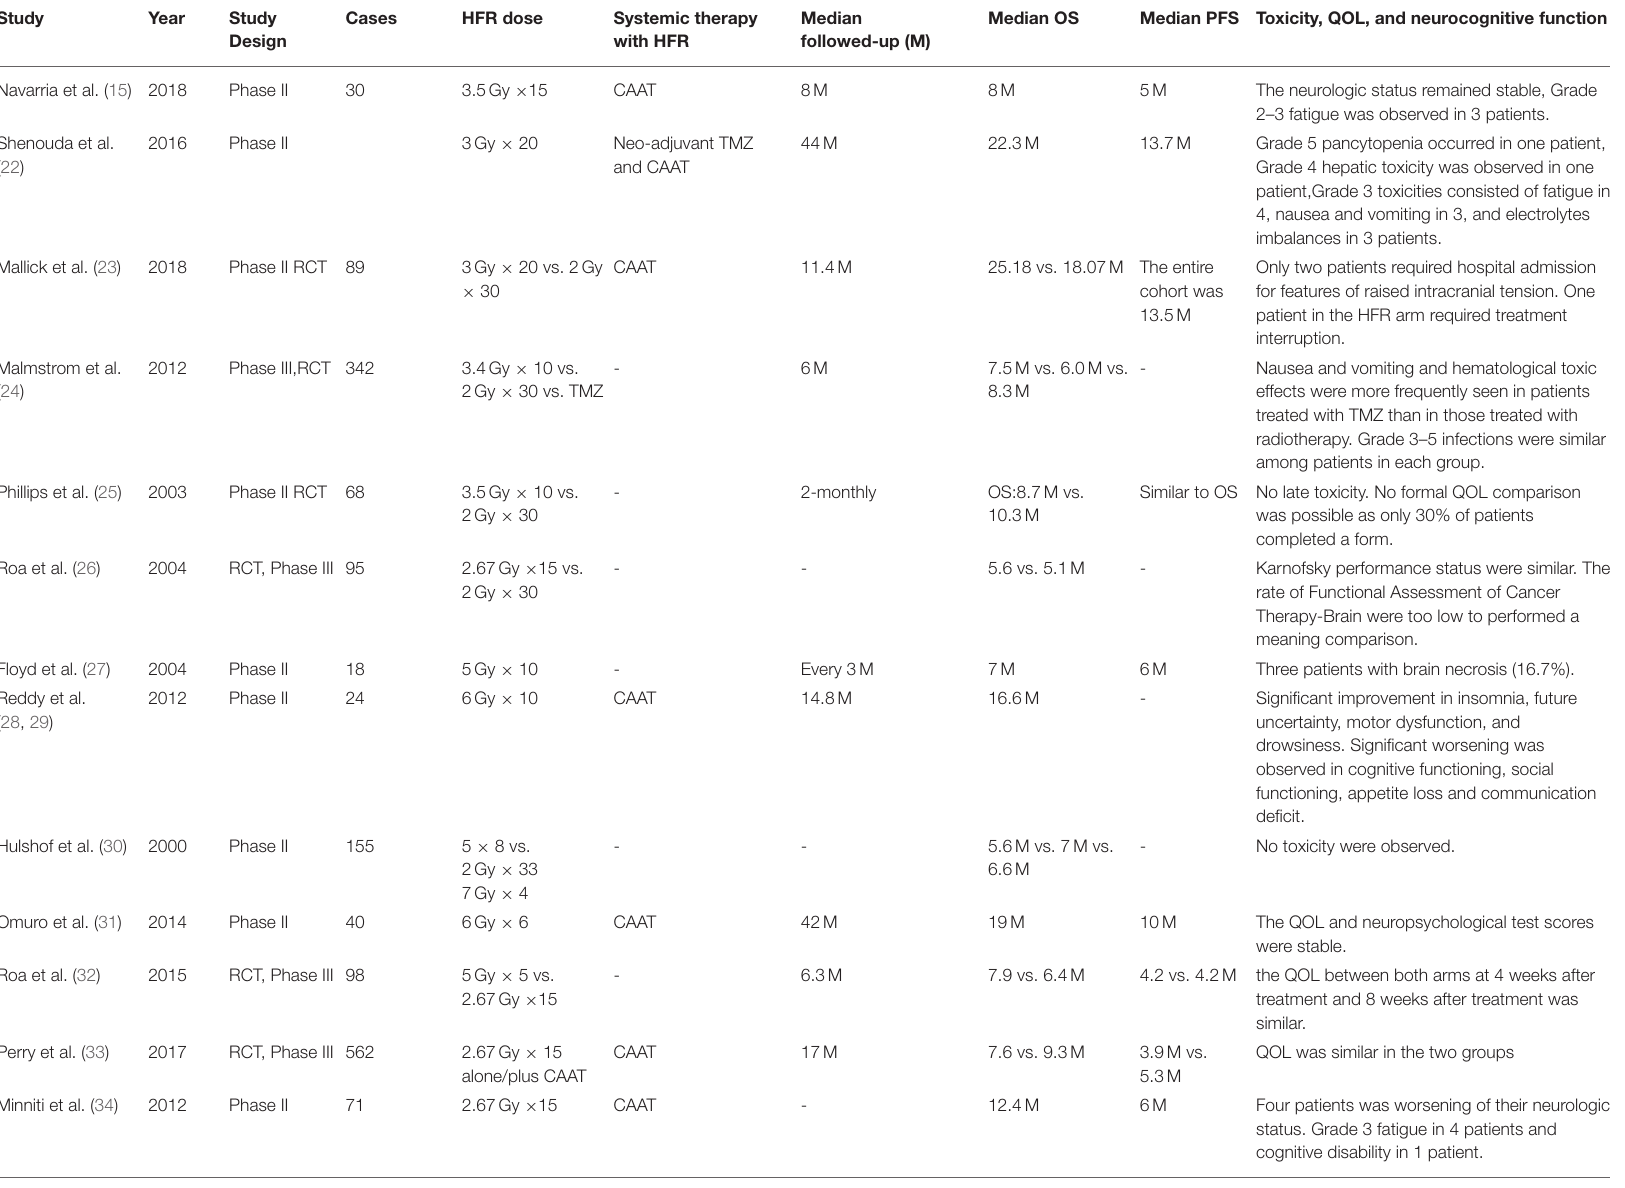
TABLE 1 | The basic information of included studies for systematic review and